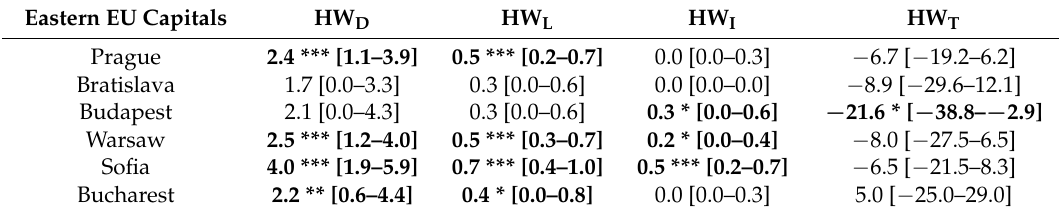
Table 3. Trend slopes (5-year change), statistically significant changes and 95% confidence interval (square brackets) of the heatwave hazard characteristics (HW D : heatwave days; HW L : long heatwaves; HW I : high-intensity heatwaves; HW T : the timing of the first simultaneously long and high-intensity heatwave) in eastern EU capitals. Significant trends are shown in